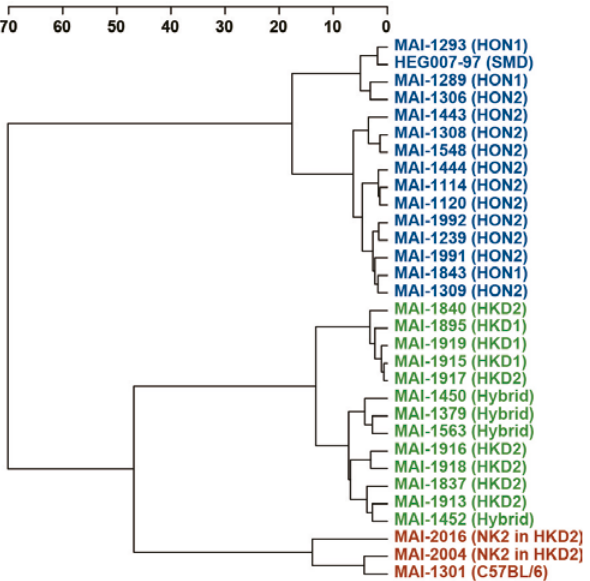
Fig. 5. Cluster analysis considering the mean numbers of chromo- somes without C-bands or with C-bands in each class. Top values indicate Euclidian